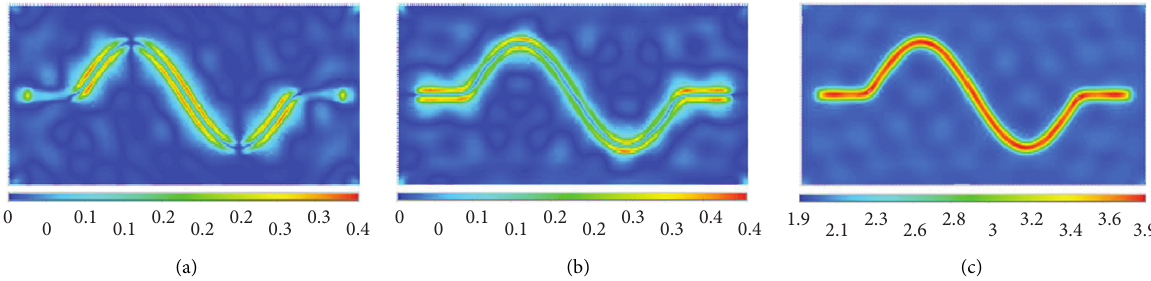
Figure 27: P wave incident ( H � 100m, f � 2.0Hz, C